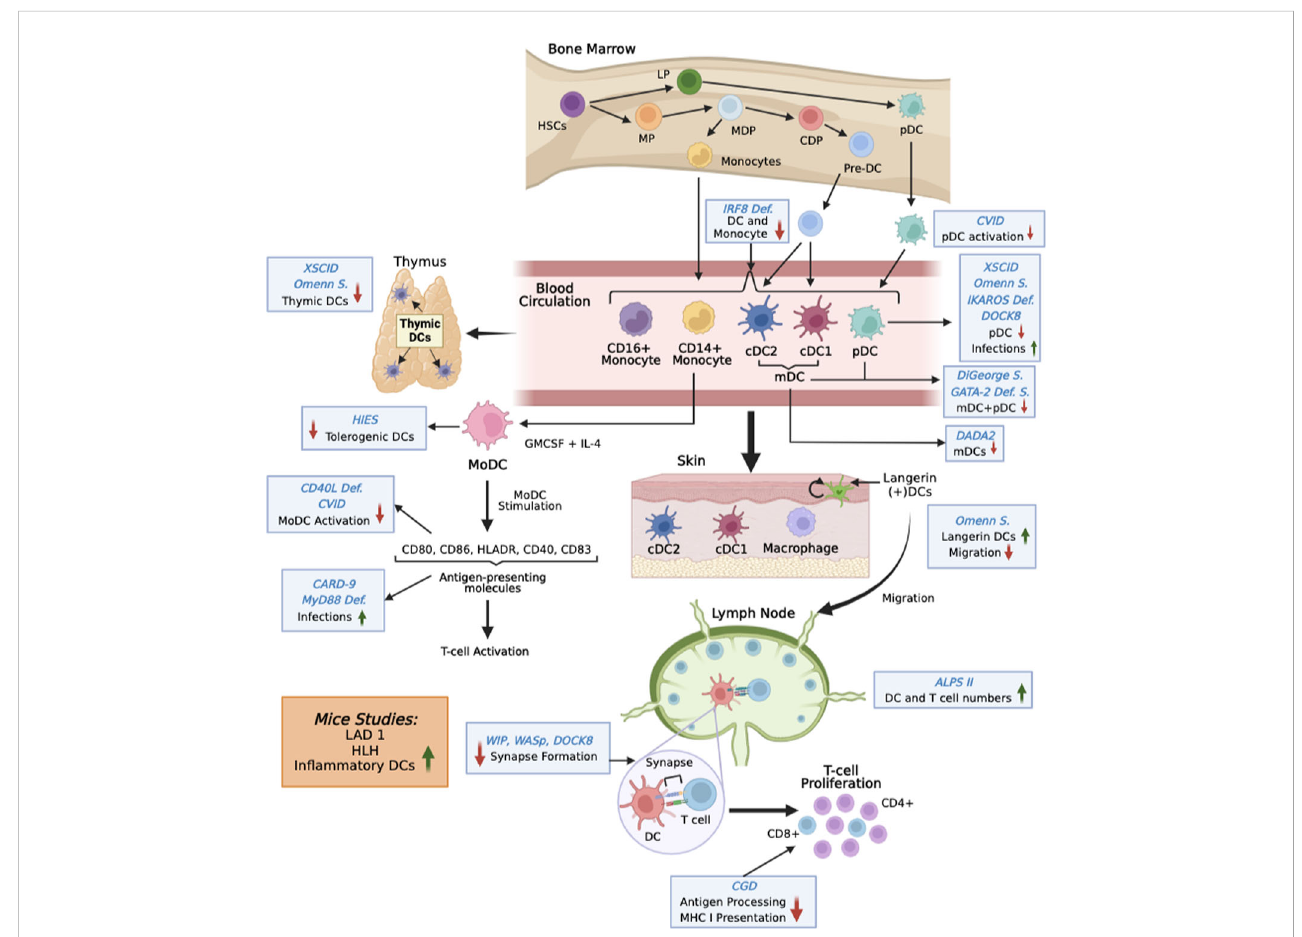
FIGURE 1 Overview of changes in DC functions in IEI. DCs develop in the bone marrow from hematopoietic stem cells (HSC). After differentiation into preDCs (for mDCs) and pDCs they leave the bone marrow and enter into the circulation. From there they populate different tissues. Monocytes can also differentiate into DCs. The fi gure shows changes in DCs at various stages in different IEIs (blue Italics). S is syndrome. Mutations studied in mice are shown in orange